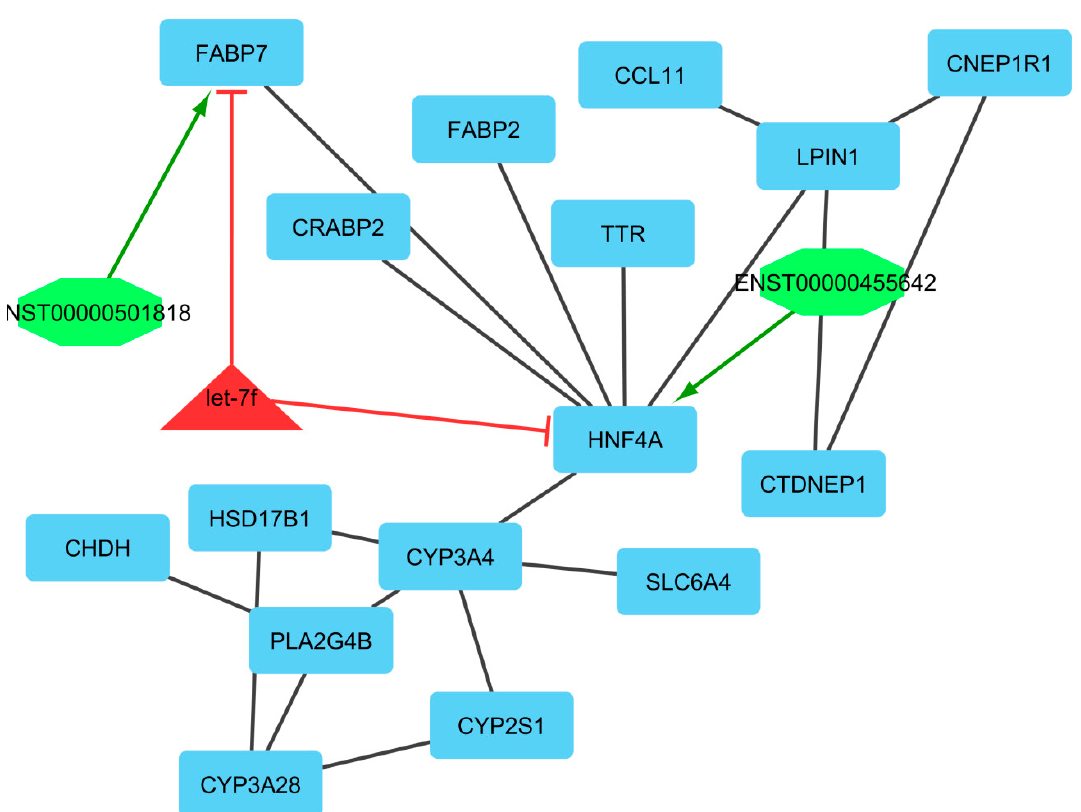
Figure 9. Module 6: 16 mRNAs/genes, 2 lncRNAs, and 1 miRNA in an interacted network were identified. In this network, the quadrilateral nodes represent mRNAs/genes, octagonal nodes represent lncRNAs, and triangle nodes represent miRNAs. Edges indicate the interactions; black edges represent mRNA–mRNA interactions, green edges represent lncRNA–mRNA interactions, and red edges represent miRNA–mRNA interactions.